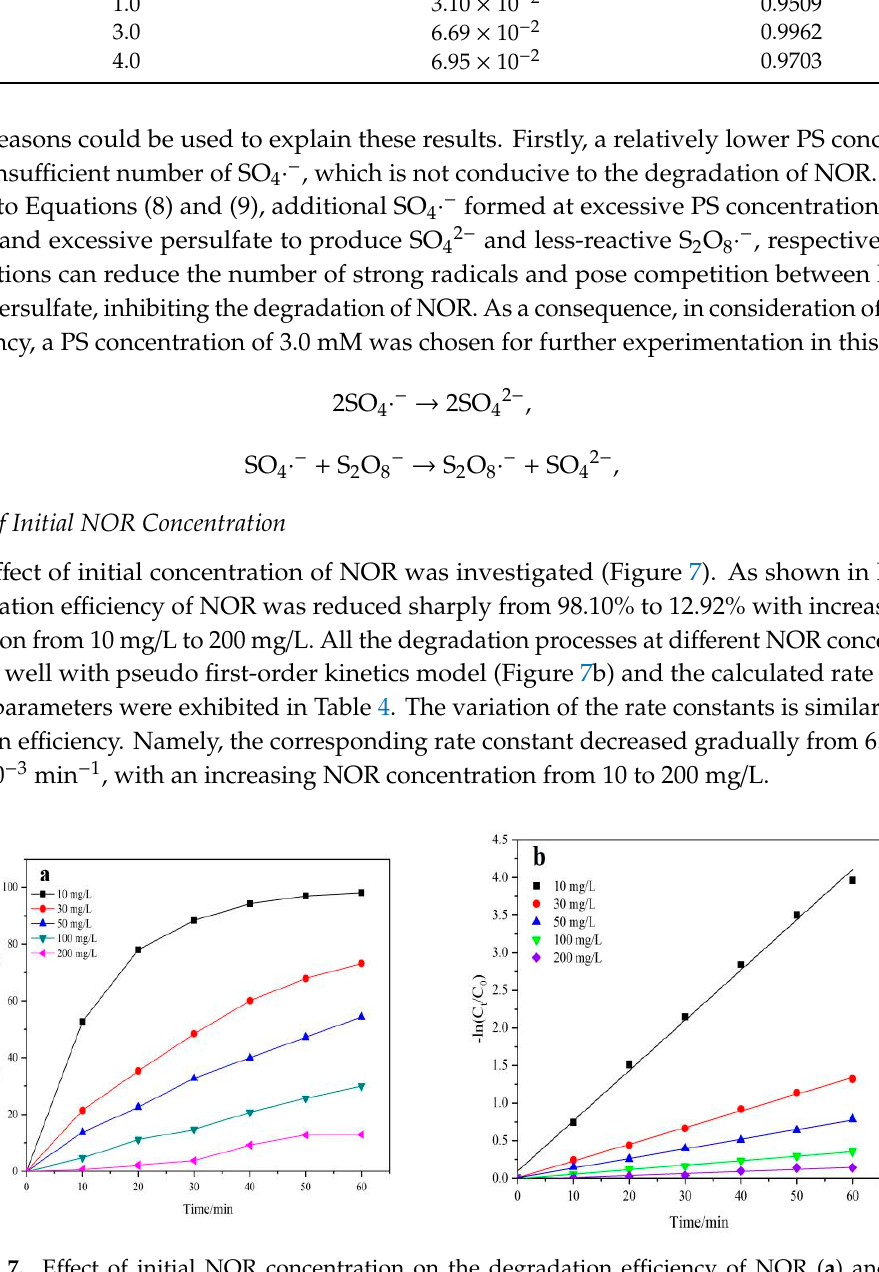
Figure 7. Effect of initial NOR concentration on the degradation efficiency of NOR ( a ) and the corresponding pseudo first-order kinetics fitting ( b ). Experimental conditions: [PS] = 3 mM, pH = 3, and electrolyte: 0.1 M Na 2 SO 4 . Table 4. The kinetic parameters of NOR degradation at different initial NOR concentrations.